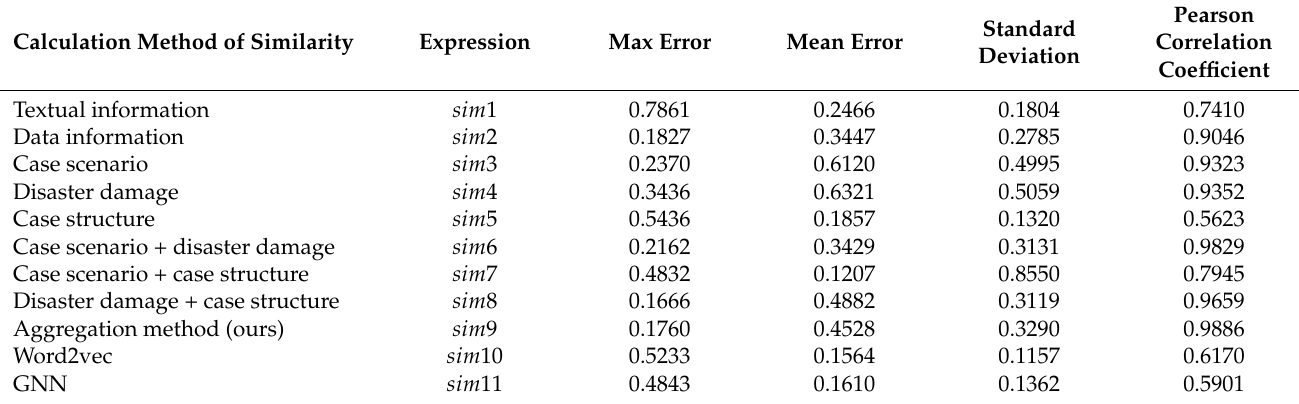
Table 3. Experimental results of similarity performance test in storm surge disaster